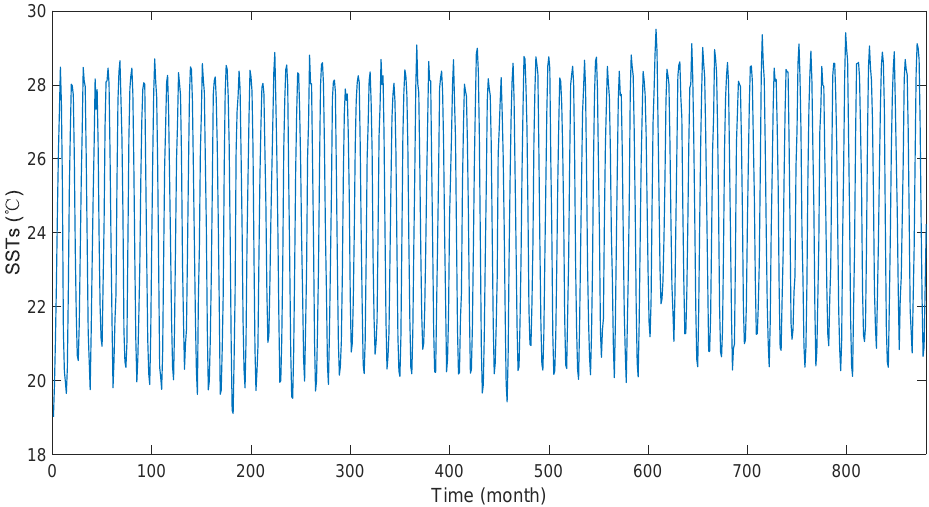
Figure 5. The series of the sea surface temperatures (SSTs) from 1948 to 2021.